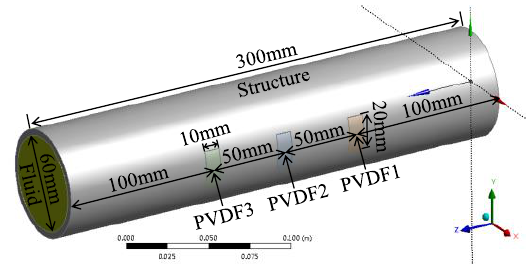
Figure 2. The geometrical model.